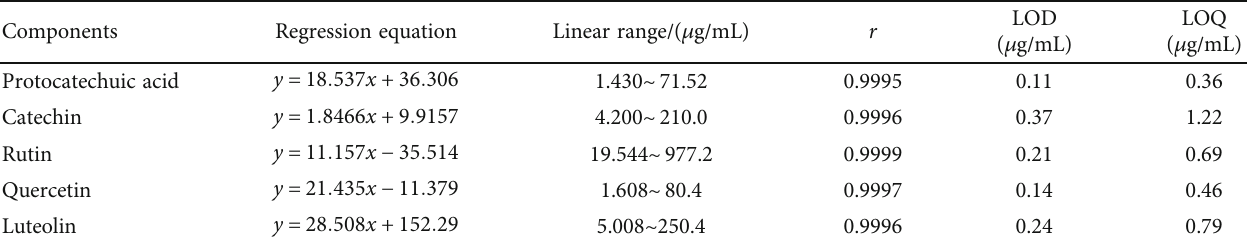
Table 2: Linear relationship of components.